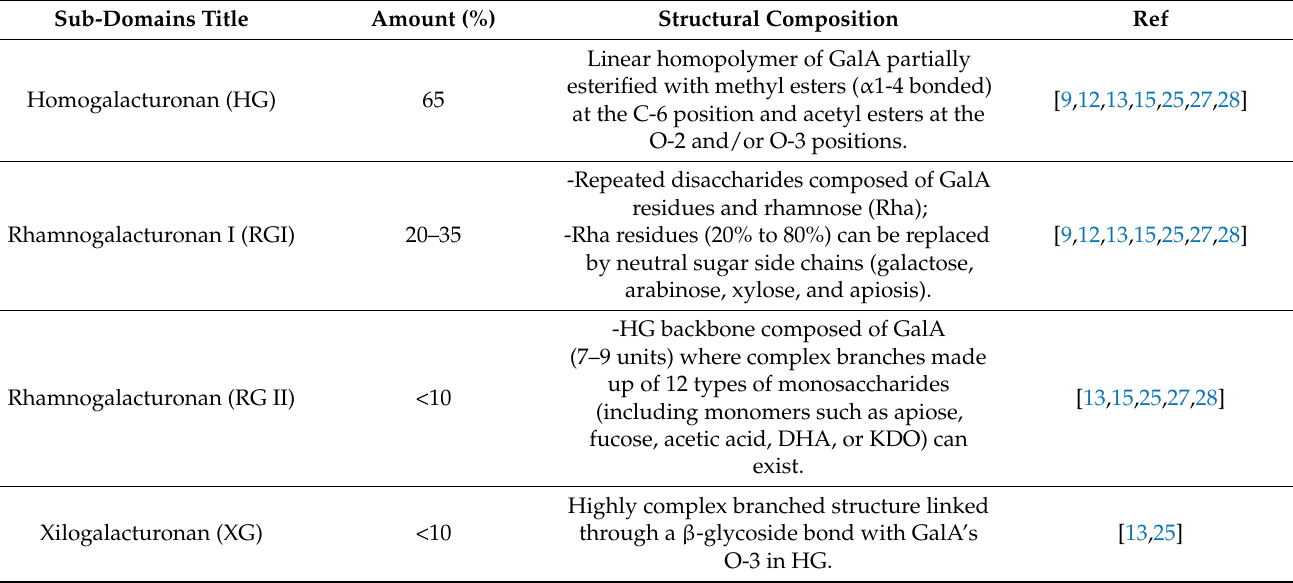
Figure 2. Chemical structure of the pectin molecule. Adapted from Maxwell et al. [25], Marenda et al. [26], Mohnen [27], and Wang et al. [14]. Table 1. Pectin structural composition.